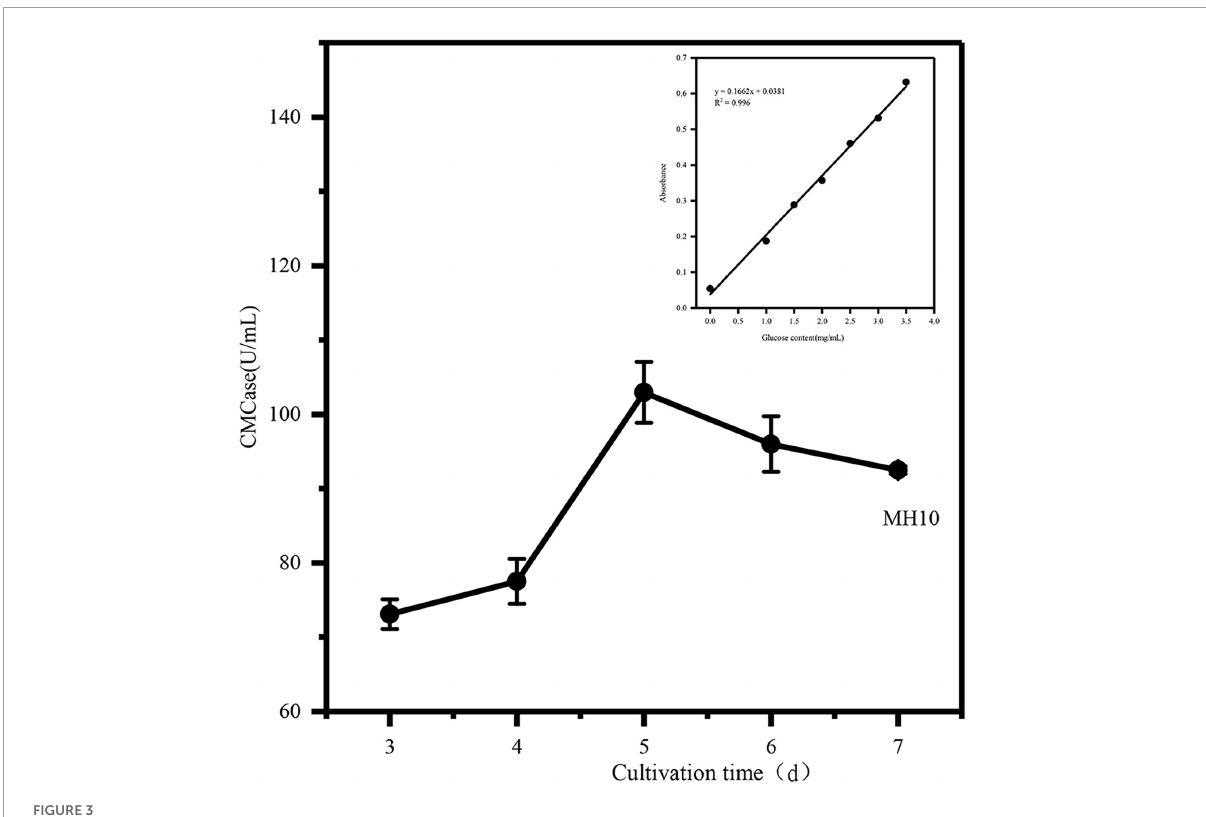
FIGURE3 Determination of CMCase enzyme activity in COC